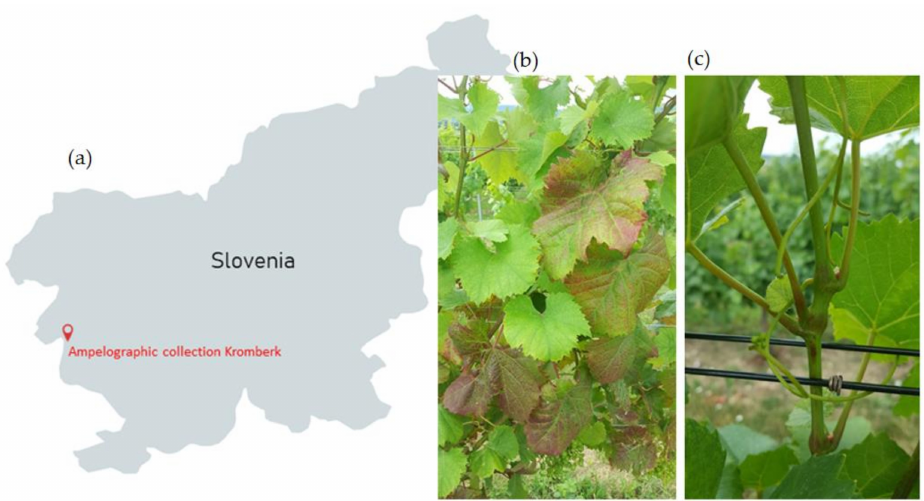
Figure 1. ( a ) Location of the Ampelographic collection Kromberk 45 ◦ 57 (cid:48) 40.8 (cid:48)(cid:48) N 13 ◦ 39 (cid:48) 44.7 (cid:48)(cid:48) E; ( b ) redding of the interveinal areas caused by GLRaV-3 on the ‘Pokalca’ variety; ( c ) shoot malformation (shorten internodes) caused by GFLV on the ‘Rebula’